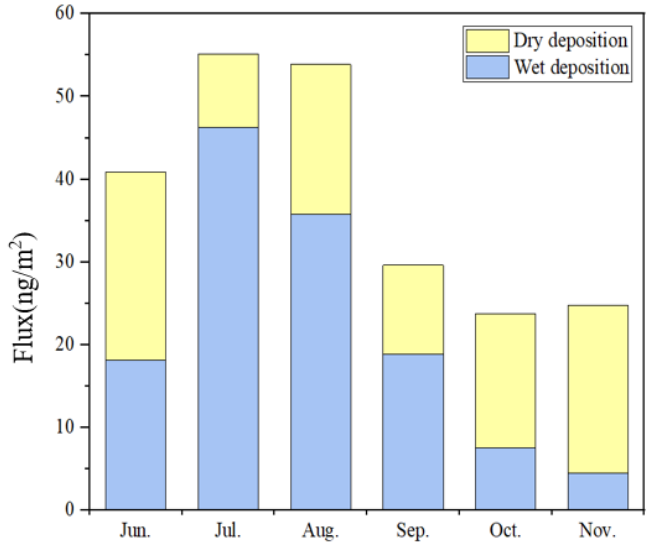
Figure 4. Wet–dry deposition flux of PFHxS from June to November Figure 4. Wet – dry deposition flux of PFHxS from June to November 2021.